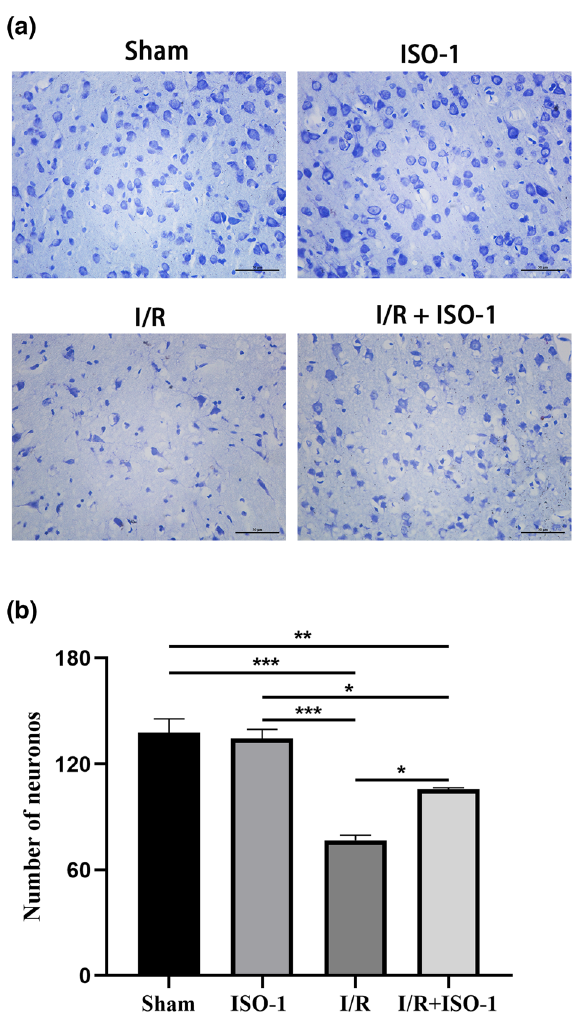
Figure 3. ISO-1 treatment rescued neuronal death after ischemia–reperfusion. ( a ) Representative micrographs of Nissl staining. Bar 50 μm. ( b ) Quantitation of Nissl-stained neurons. * P < 0.05, ** P < 0.01, *** P <